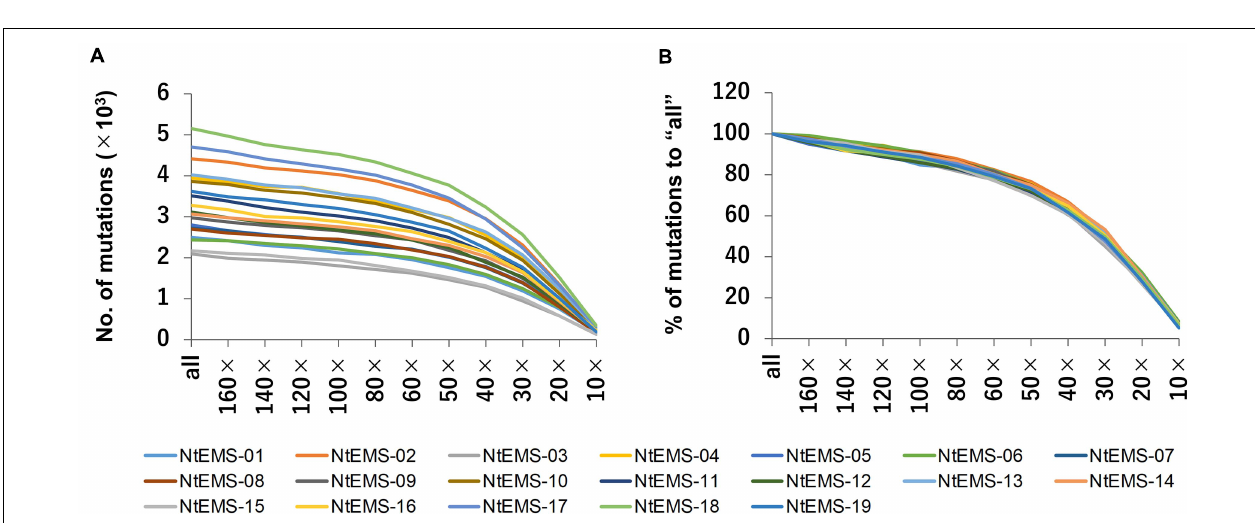
FIGURE 3 | Target and mutation density among the 24 chromosomes in the 19 NtEMS lines. Target coding sequence (CDS) and mutation densities in the 10-Mb genomic segments are shown in the heatmap. The heatmap scale was defined separately for each of the 19 NtEMS lines based on the lowest and highest values in each dataset (horizontal direction), and not globally normalized; therefore, each small bar plot indicates the normalized density in each dataset. The mutation density was largely proportional to the target CDS density in the segment, and had no clear bias.